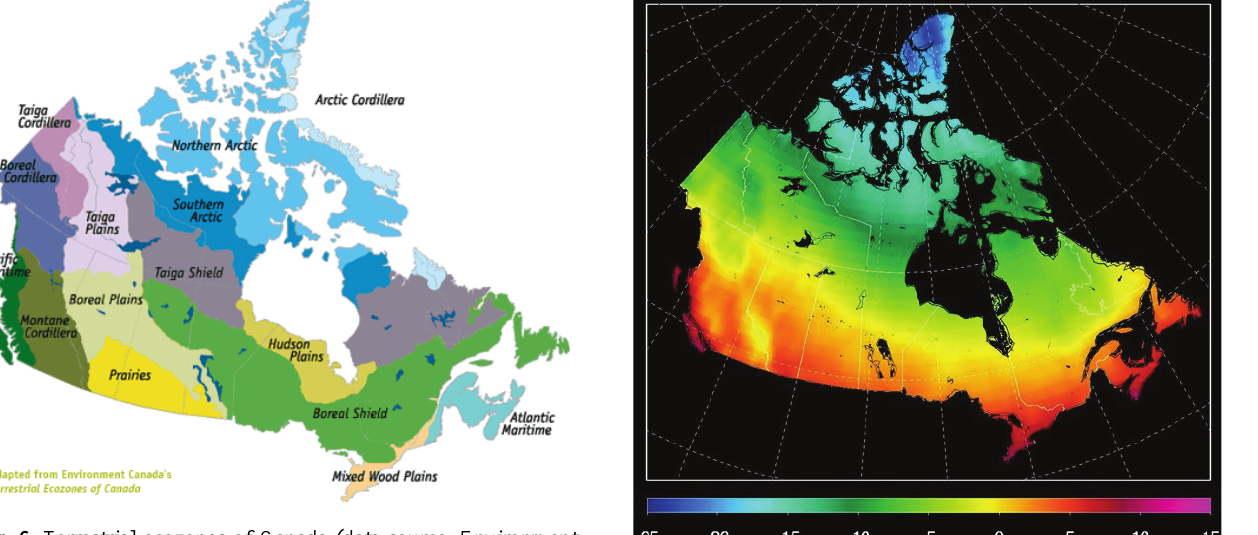
Fig. 6. Terrestrial ecozones of Canada (data source: Environment Canada http://www.evergreen.ca/).